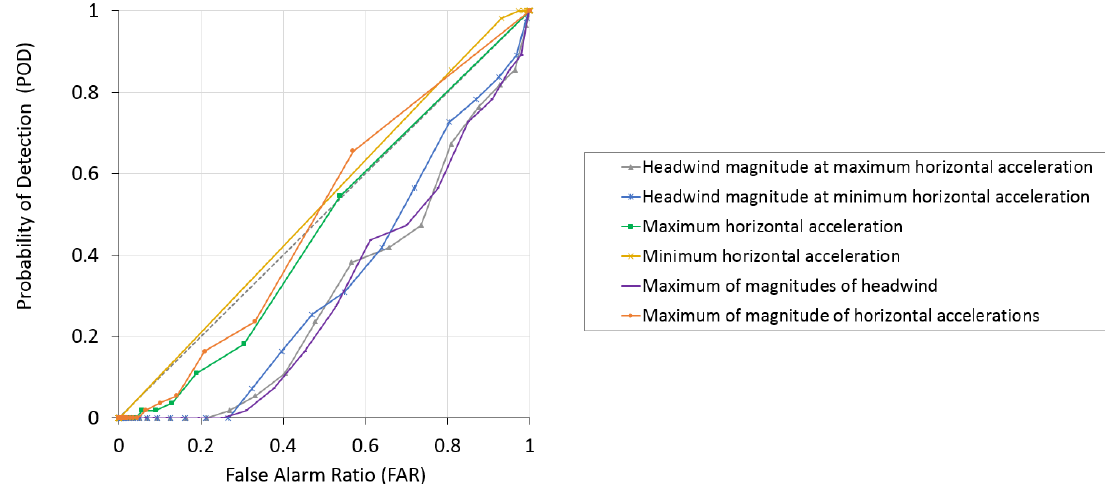
Figure 11. Example receiver operating characteristic curves for all metrics calculated for 25RA typ- ical wind speed with horizontal acceleration.